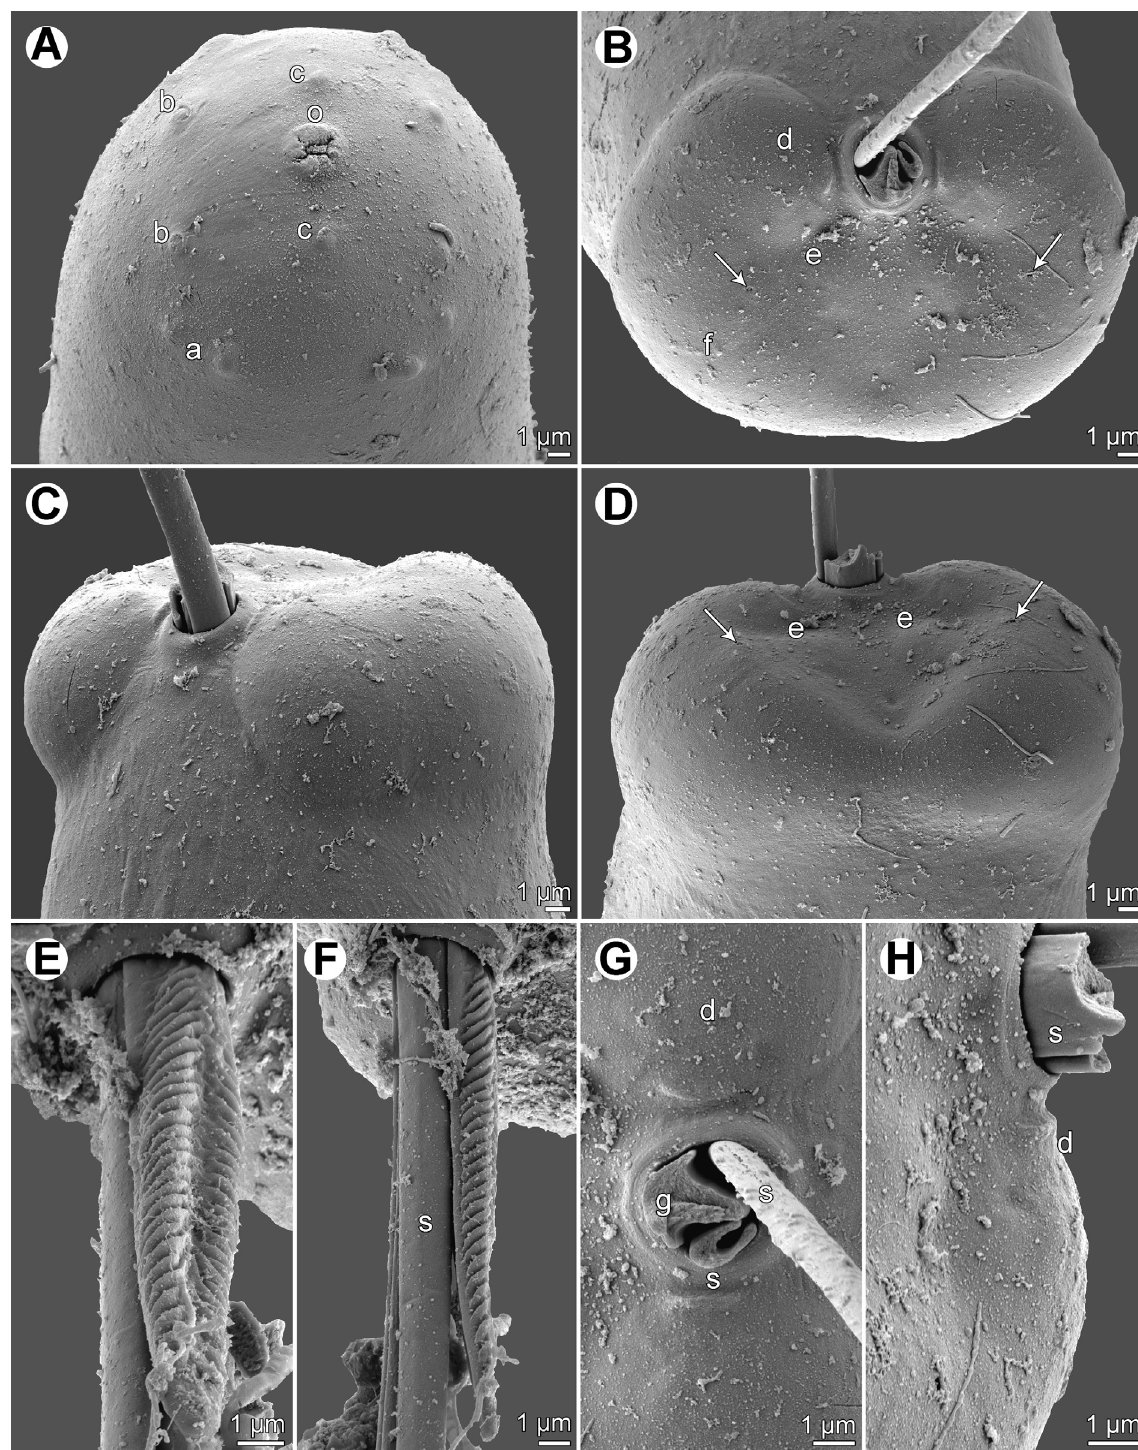
Figure 4. Philometra jordanoi (López-Neyra, 1951), scanning electron micrographs of male. A: Cephalic end, subapical view. B: Caudal end, apical view (arrows indicate phasmids). C: Same, sublateral view. D: Same, dorsal view (arrows indicate phasmids). E, F: Distal end of gubernaculum, dorsal and lateral views, respectively. G, H: Region of cloaca, ventral and dorsal views (distal ends of gubernaculum and one spicule broken-away). Abbreviations : a, submedian pair of external cephalic papillae; b, submedian cephalic papilla of internal circle; c, lateral cephalic papilla of internal circle; d, group of four adanal caudal papillae; e, large papilla posterior to cloaca; f, caudal mound; g, gubernaculum; o, oral aperture; s,